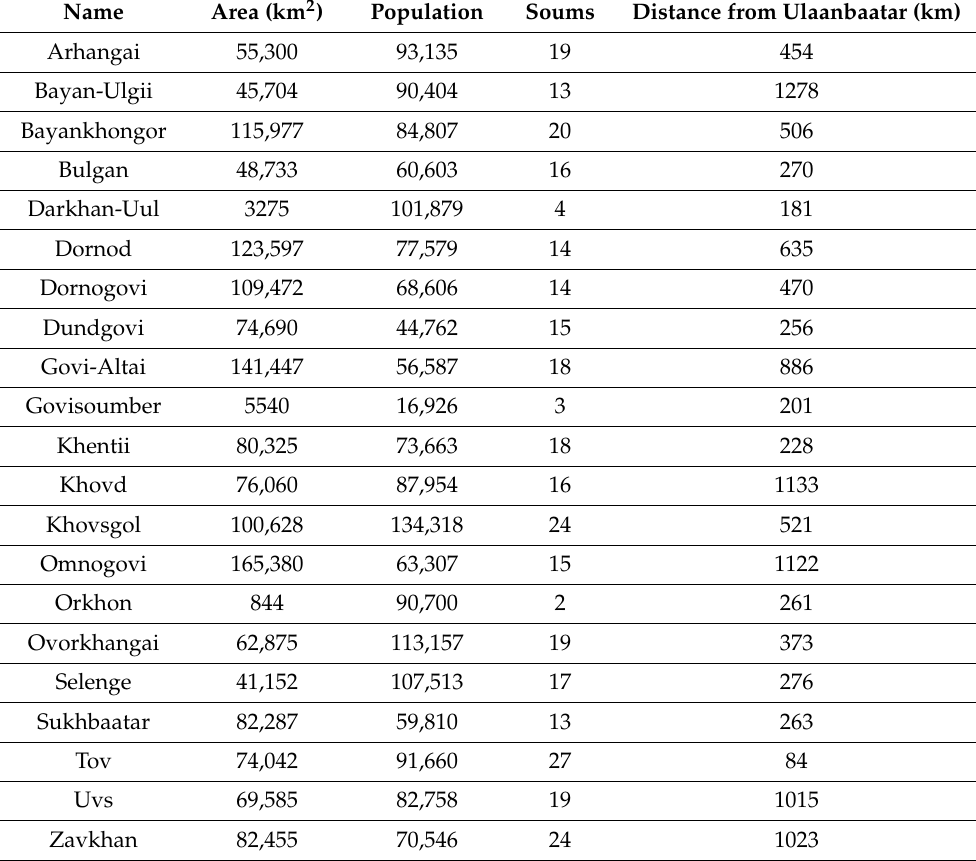
Table 4. Information about each province in